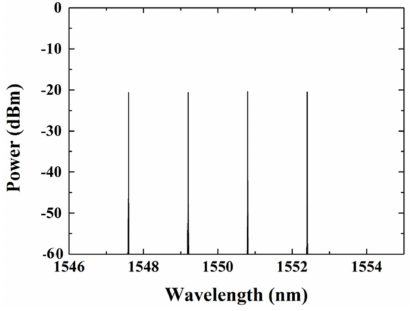
Figure 7. The spectrum of odd signals at the output port 1 realizing OXC functionality.